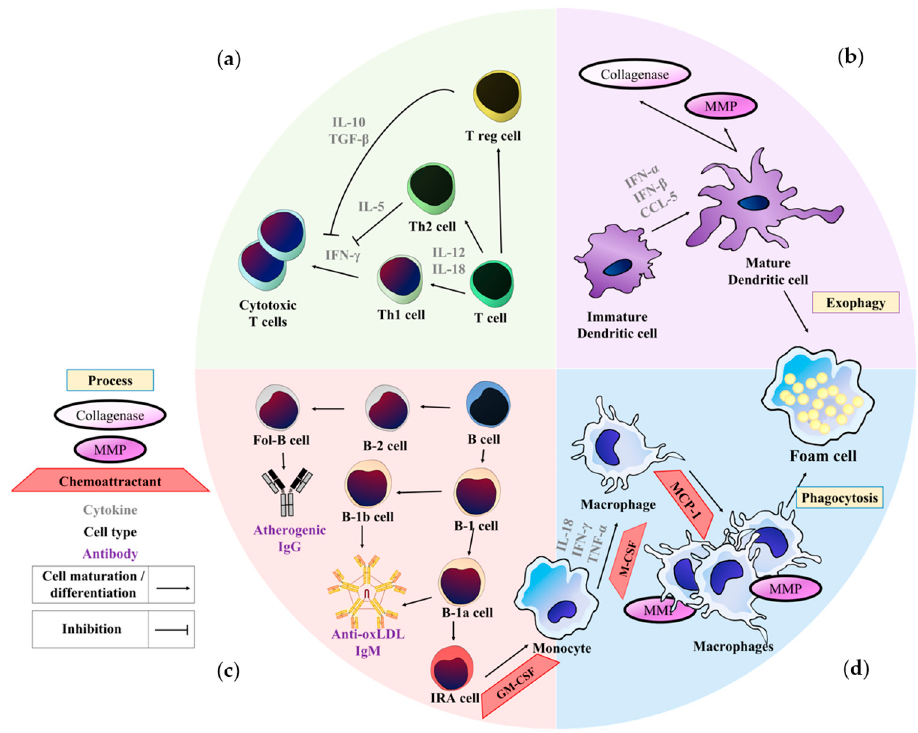
Figure 1. Role of monocytes, macrophages, dendritic cells, T-cells, and B-cells in atherosclerosis: ( a )